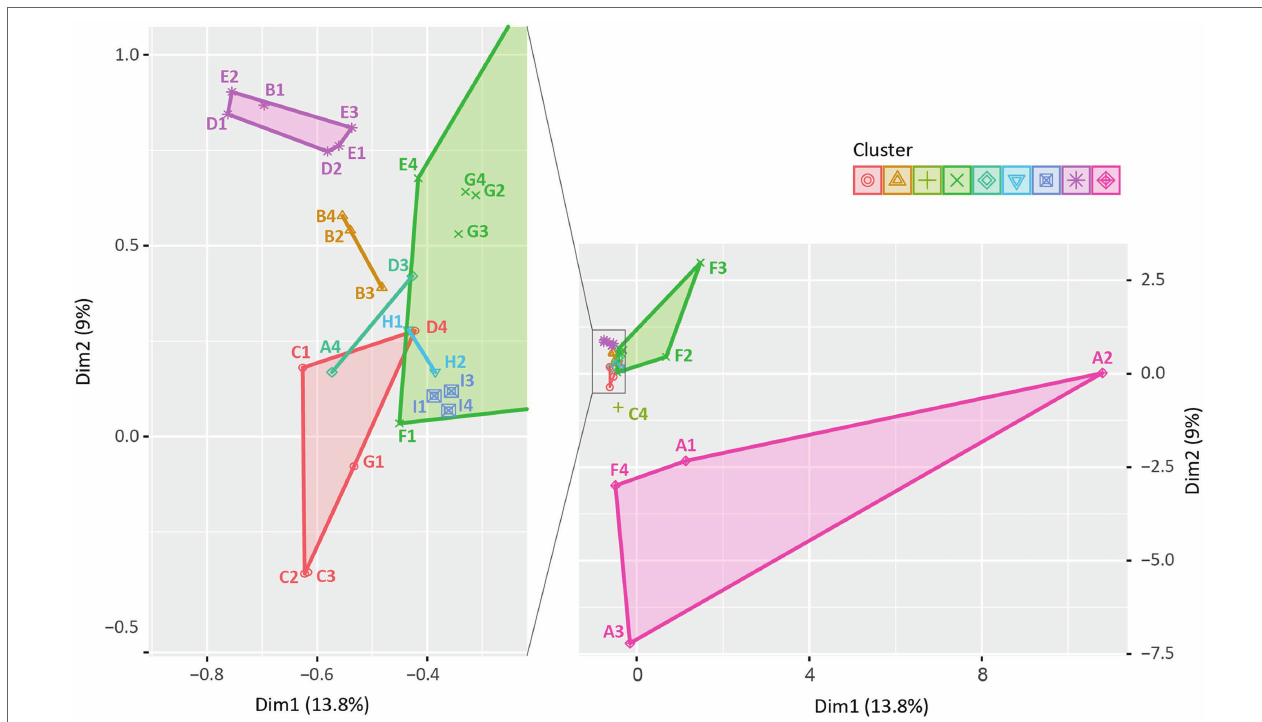
FIGURE 6 | k -means similarity clustering plot: similarity in the clonal distribution among swine production stages within farms. A total of 33 points were described and clustered into 9 (symbols and colors) using the k -means similarity clustering algorithm based on Euclidean distance. The k -means cluster plot was generated using the R software (ver. 4.3.2). Each point indicates the distribution of STs among swine production stages in each farm, consisting of 36 points based on combination of 9 farms (A to I) and 4 production stages (1, weaning piglets; 2, growing pigs; 3, finishing pigs; and 4, pregnant sows; e.g., A1 presents the clonal distribution of “Weaning piglets” of “Farm A”). Three points (H2, H4, and I2) were excluded as no ESBL/AmpC-EC strains were isolated from “Growing pigs” of “Farm H”, “Pregnant sows” of “Farm H,” and “Growing pigs” of “Farm I.”